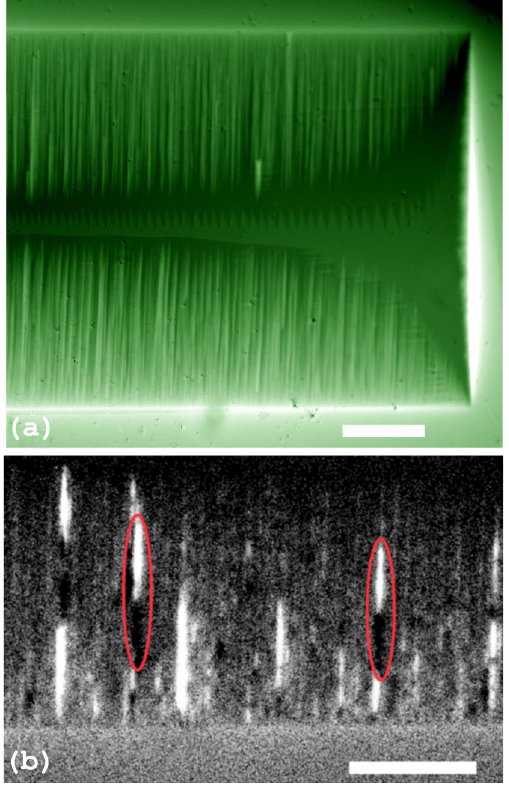
film on a NdGaO substrate with a terrace-structured surface. Also shown is the orientation of the crystallographic axes specified by Miller indices, as well as the tilt angle (cid:2) . On top of the superconductor is the Faraday rotating ferrite-garnet film (FGF), grown on a gadolinium-gallium-garnet (GGG) substrate, which allows realtime visualization of the flux density across the film area.